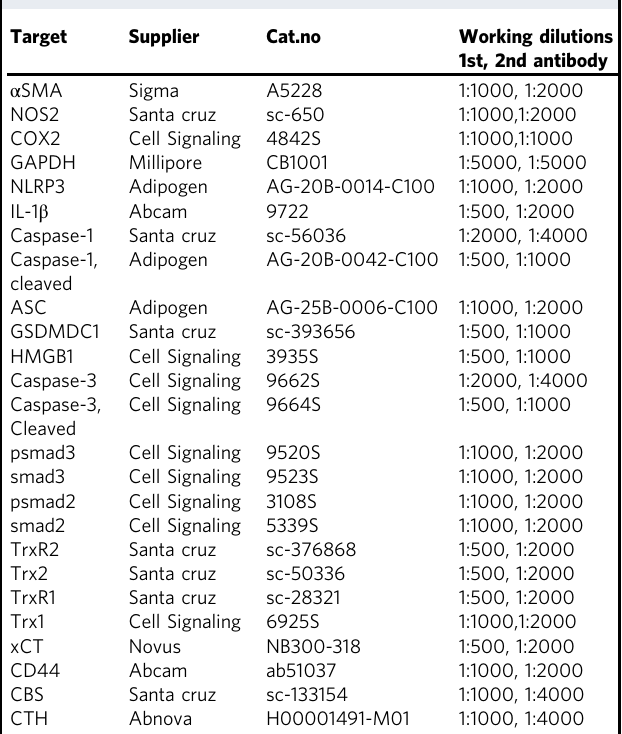
Table 1 Antibodies. Target